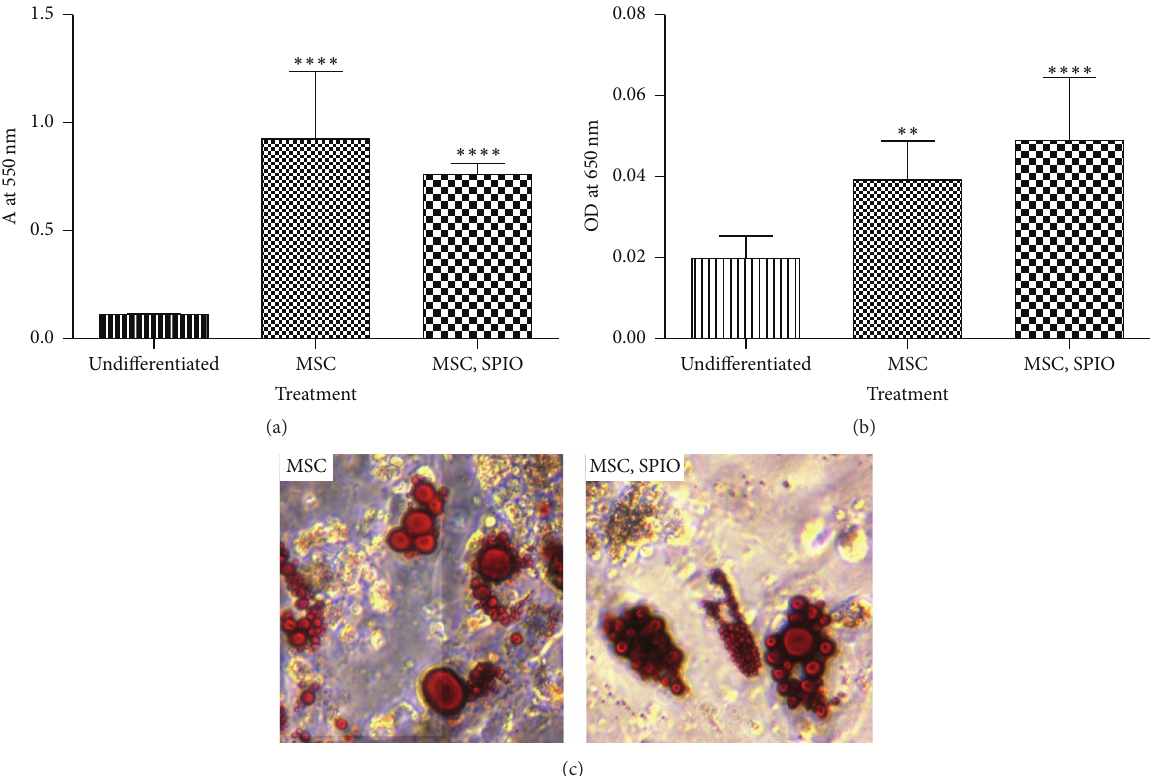
Figure 3: Trilineage differentiation data demonstrating (a) osteogenesis as measured by calcium production ( ∗∗∗∗ 𝑝 < 0.0001 ), (b) chondrogenesis as measured by Alcian Blue uptake in cell pellets ( ∗∗ 𝑝 < 0.01 , ∗∗∗∗ 𝑝 < 0.0001 ), and (c) adipogenesis as noted by lipid deposition visualized with Oil Red O.